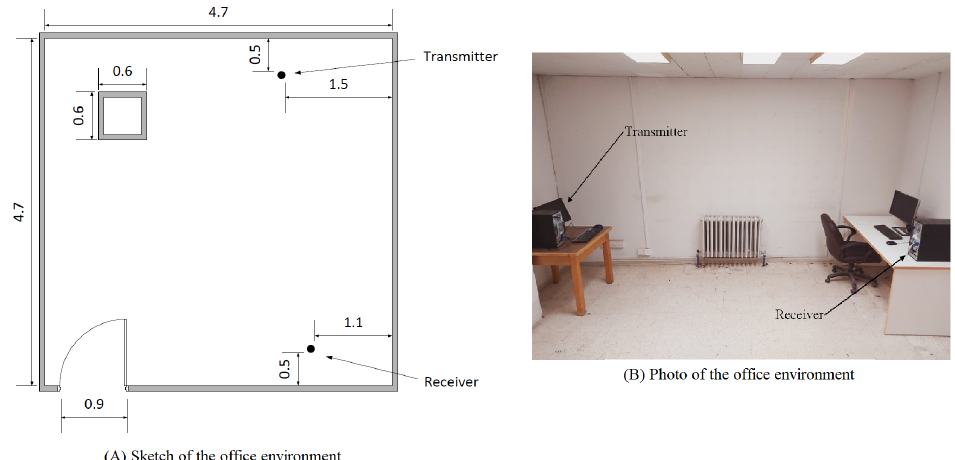
Figure 4. The office environment used for data collection. All dimensions are in